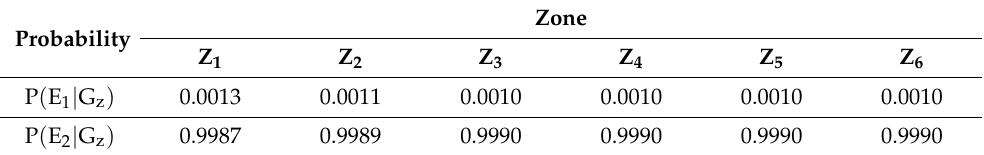
Table 24. The Calculated Probability of Type I and Type II Earthquakes in Cluster Type II.